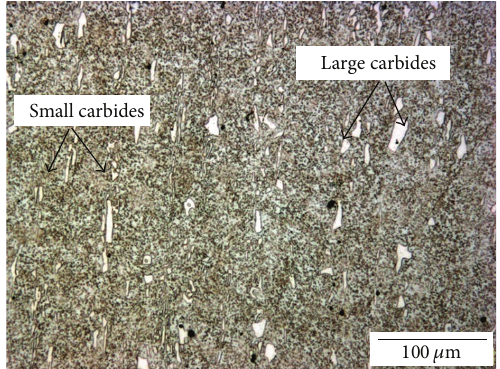
Figure 4: Optical micrographs of as-received AISI D2 tool steel.